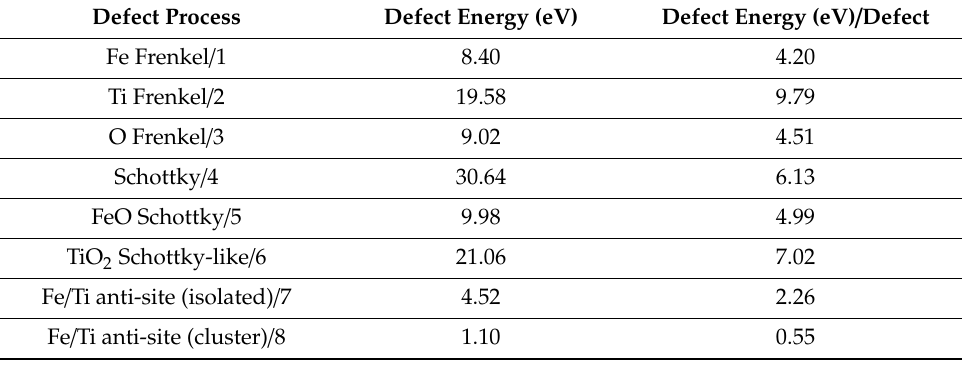
Figure 2. Schematic diagrams showing vacancy, interstitial, and anti-site defects; and calculation formulae of defect processes. Table 2. Calculated energies of Schottky, Frenkel, and anti-site